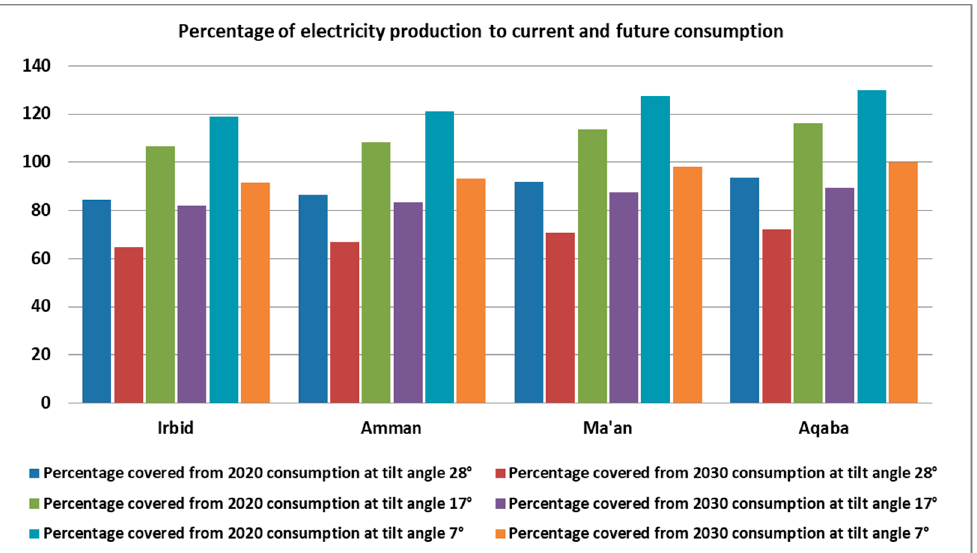
Figure 12. A comparison between electricity production from installing PV systems on the rooftops of apartment buildings type A1 in relation to its current and future energy consumption.